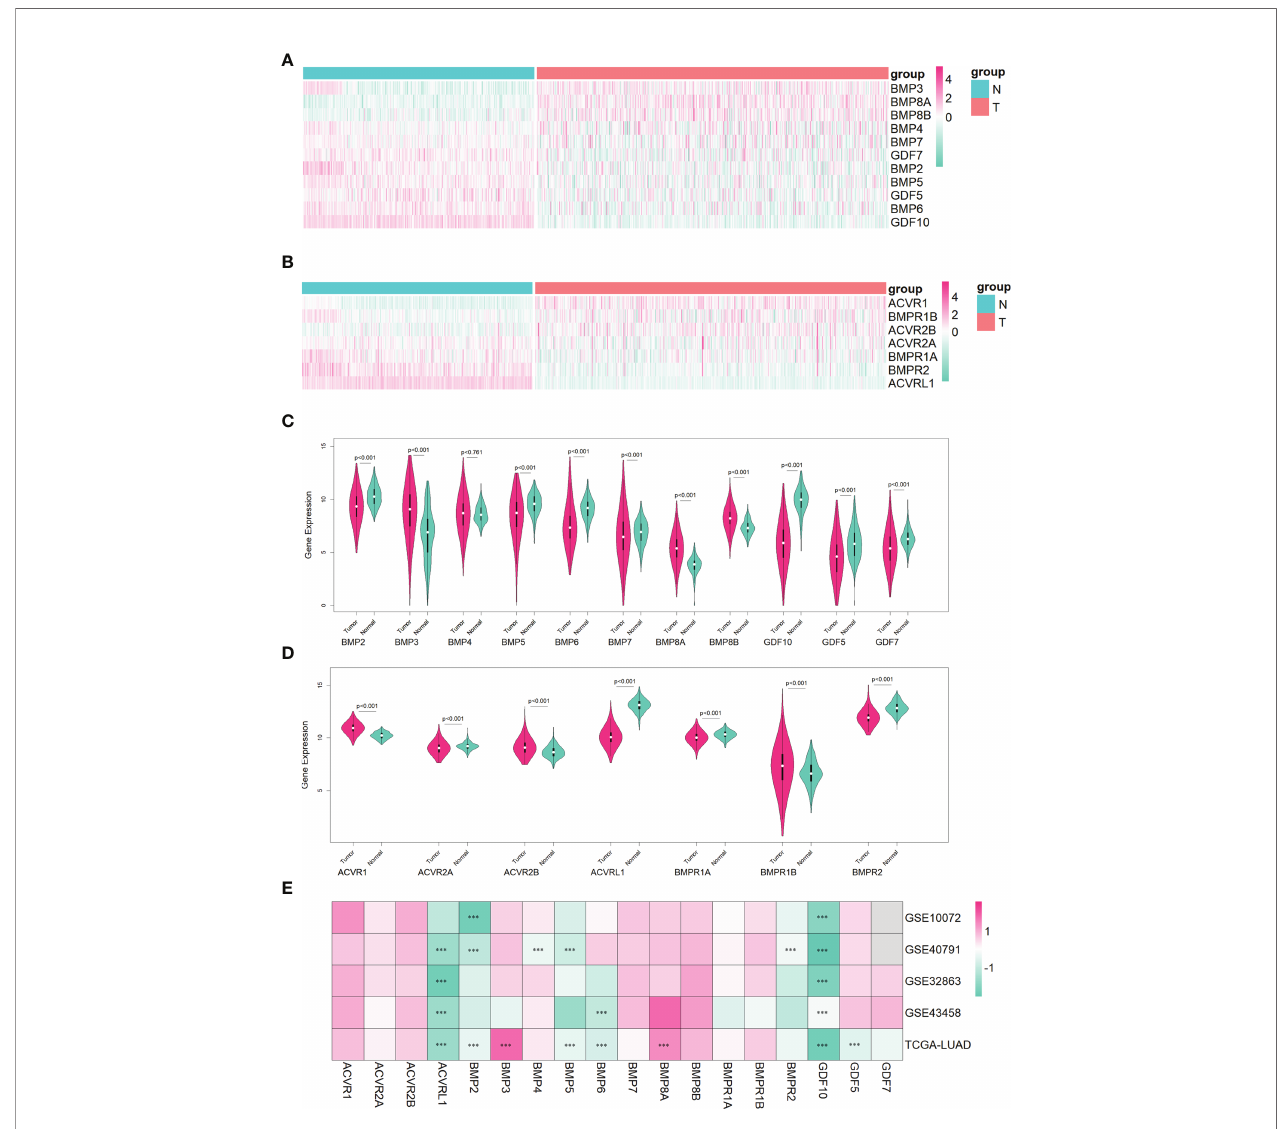
FIGURE 2 | The identi fi cation of differentially expressed BMPs/BMPRs in the training dataset combining TCGA-LUAD and GTEx-LUNG, and the veri fi cation of four GEO datasets in lung adenocarcinoma. (A) Heatmap of differential expression analysis for 11 BMPs in the training dataset. (B) Heatmap of differential expression analysis for seven BMPRs in the training dataset. (C) Violin plot indicating the expression of 11 BMP expression between tumor and normal tissues in the training dataset. (D) Violin plot indicating the expression of seven BMPRs between tumor and normal tissues in the training dataset. (E) Heatmap of differential expression analysis for 11 BMPs and 7 BMPRs in four GEO validation datasets. (C, D) The white point represents the median Q2, the black bar ranging from the lower quartile Q1 to the upper quartile Q3 represents the dispersion and symmetry of the non-abnormal data, the black line running through the violin plot represents the maximum and minimum non-abnormal values, and the outer shape of the violin plot is the kernel density estimation. (E) Every cell representing differentially expressed BMPs/ BMPRs in each dataset is labeled with p -value